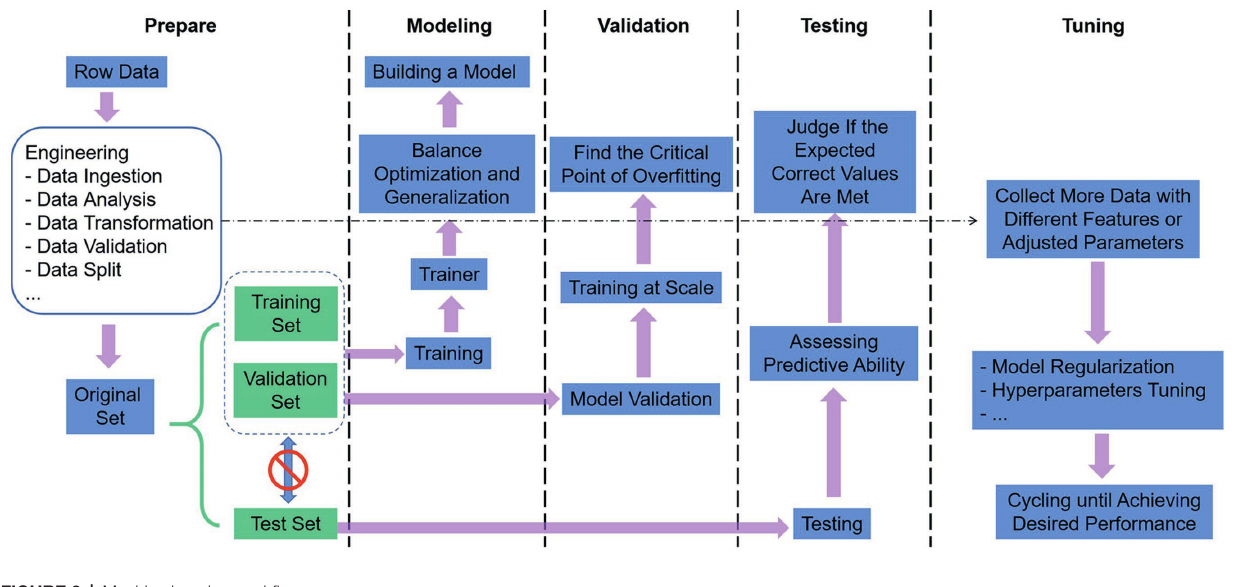
FIGURE 3 | Machine learning